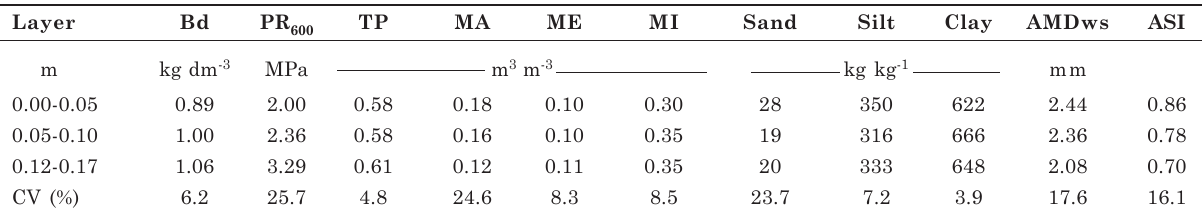
Table 2. Physical properties of an Hapludox after twelve years of pig slurry applications, which did not show differences among application rates (averaged across pig slurry treatments)